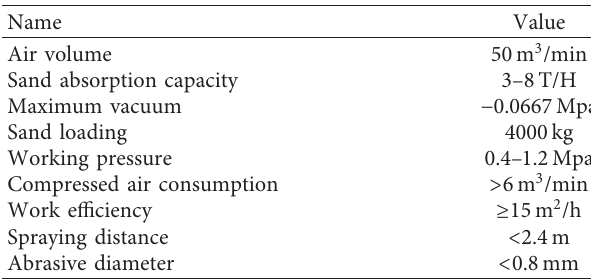
Table 2: Main working parameters of sandblasting